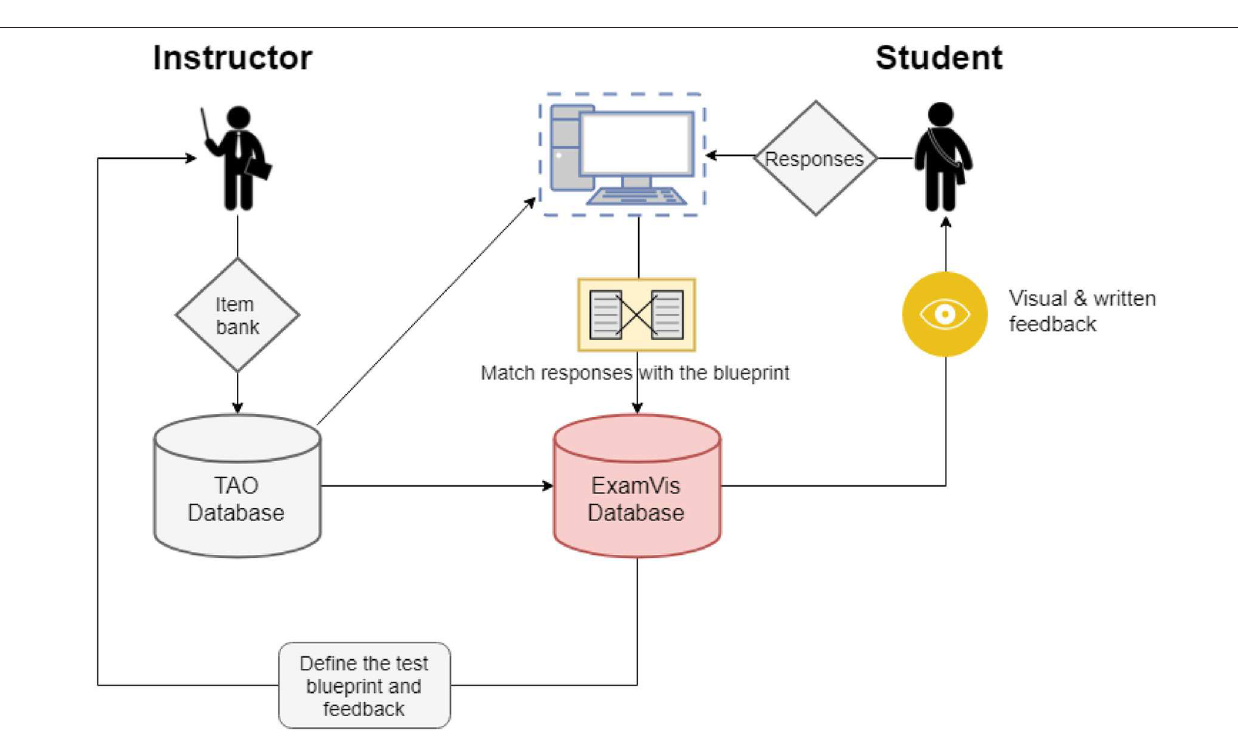
FIGURE 2 | A flowchart of the ExamVis score reporting